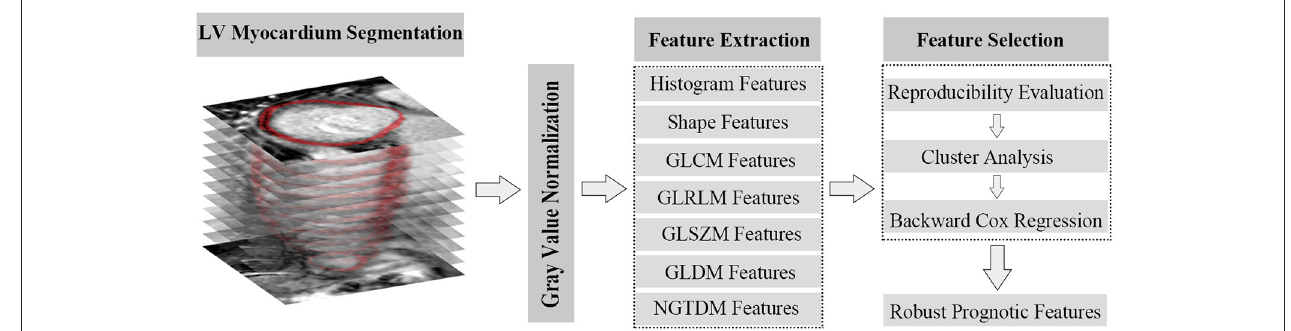
FIGURE 1 | Flowchart of textures extraction and selection.